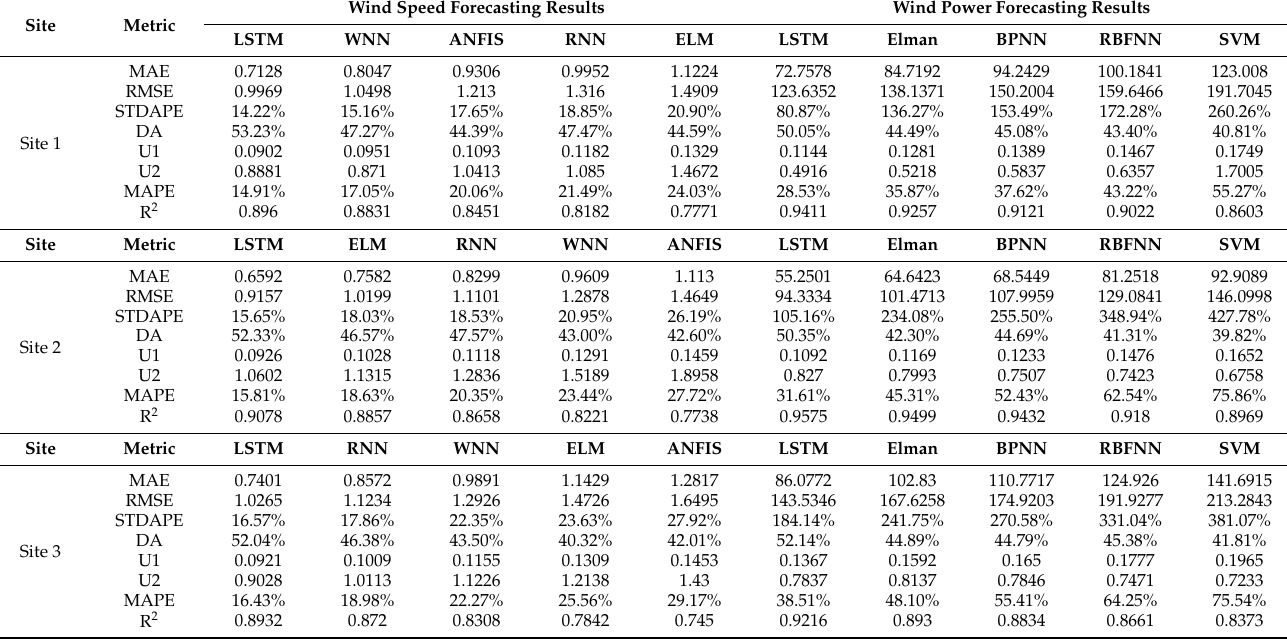
Table A3. The forecasting performance of five optimal sub-models for wind speed and wind power in the third season.